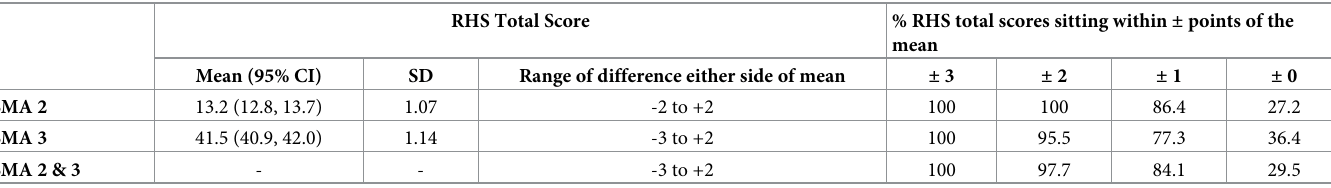
Table 1. Inter-rater reliability n = 22 raters.